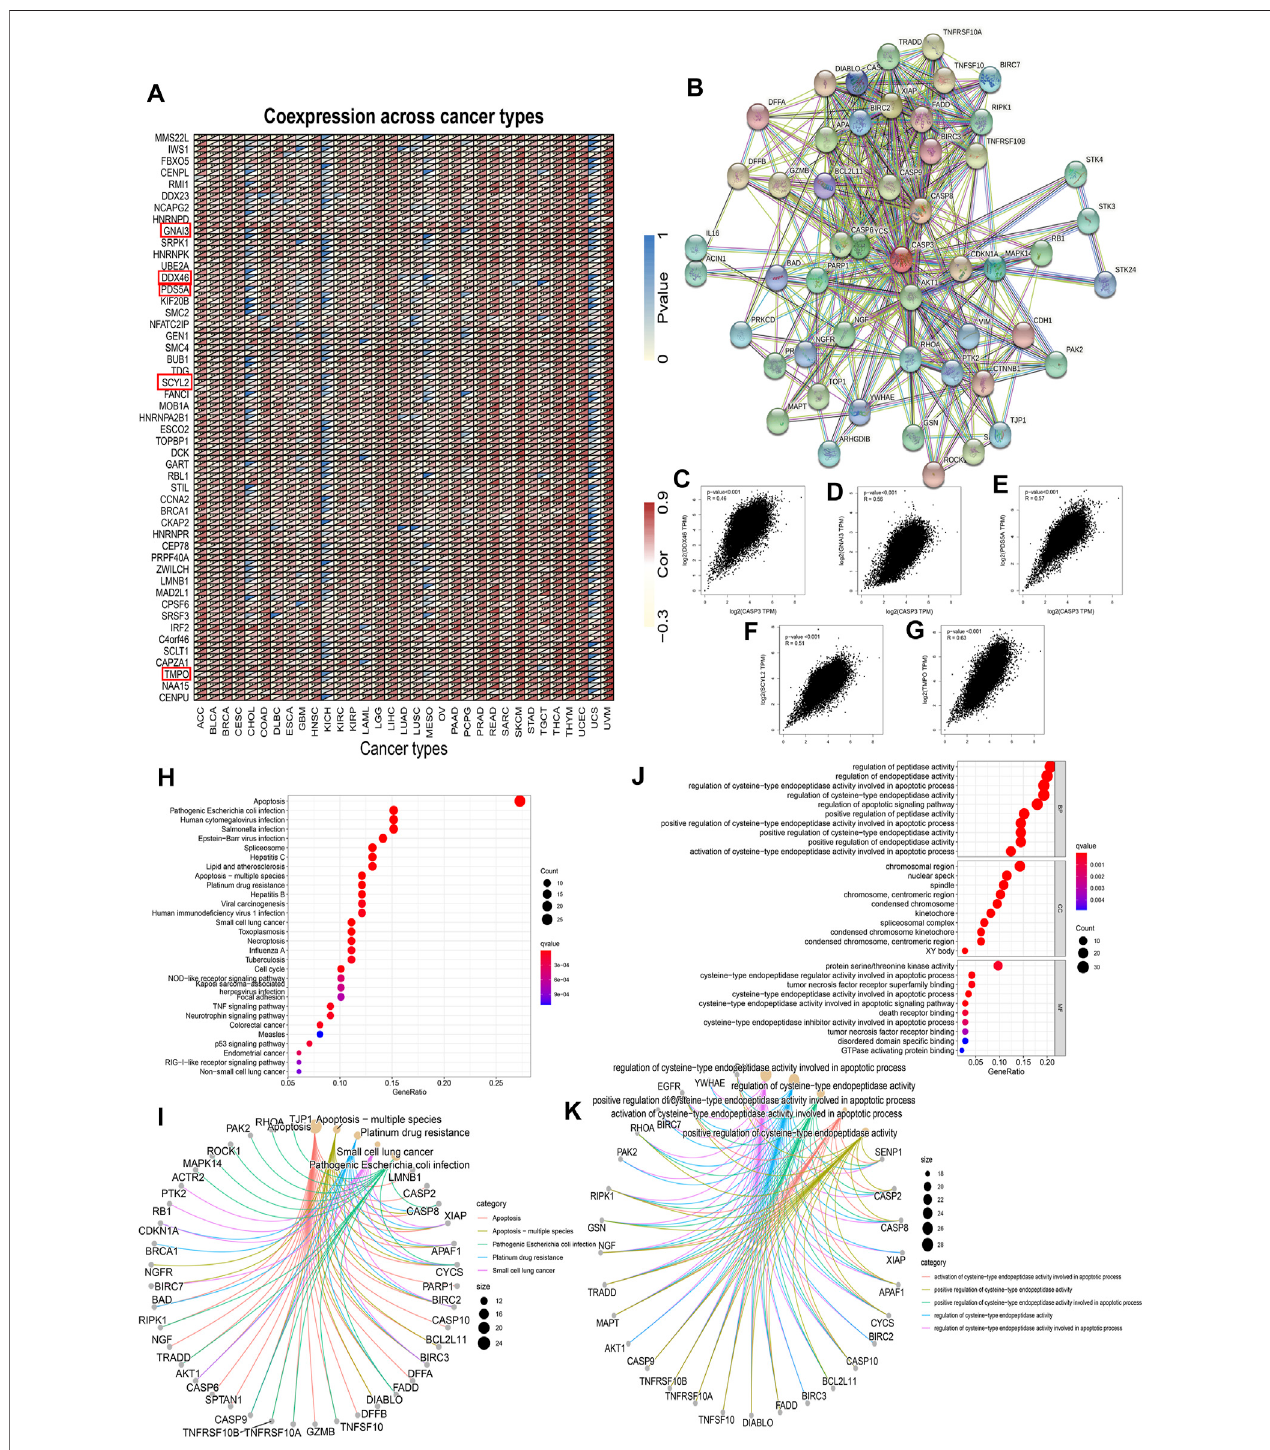
FIGURE12 | CASP3 -related gene enrichmentanalysis. (A) Relationshipbetween the CASP3 and the fi rst 100 genesin different tumours. The triangle in the upper left corner represents the p -value, and the triangle in the lower right corner represents the correlation coef fi cient. * p < 0.05, ** p < 0.01, *** p < 0.001. (B) Interaction of CASP3 with the binding protein ofthe fi rst 50. (C – G) Relationship between CASP3 and the expression ofselected genes( DDX46 , GNAI3 , PDS5A , SCYL2 , TMPO ) (H,I) basedon CASP3 -bindingandcorrelatedgeneKEGGenrichmentanalysisresults,and (J,K) basedon CASP3 -bindingandcorrelatedgeneGOenrichmentanalysis